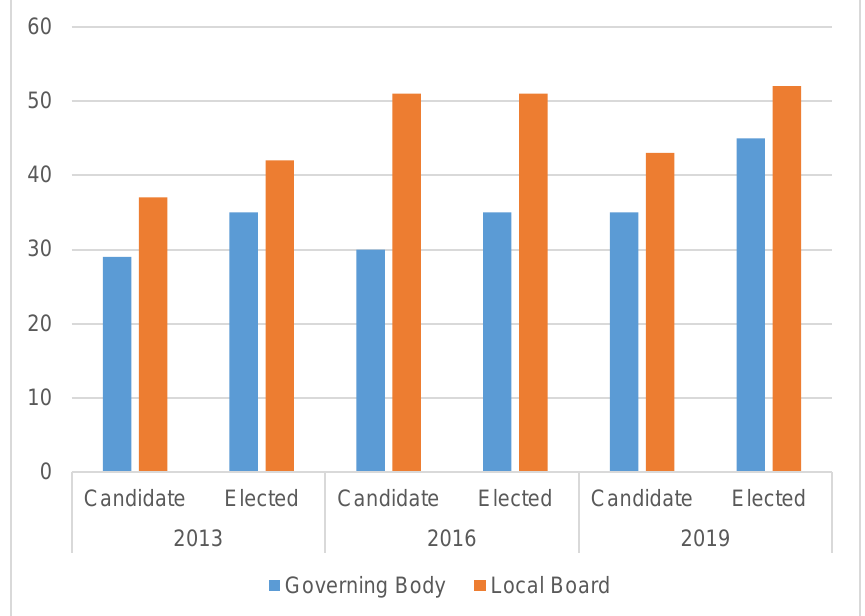
Figure 3: Women’s electoral success by governing body and local boards (percentage of